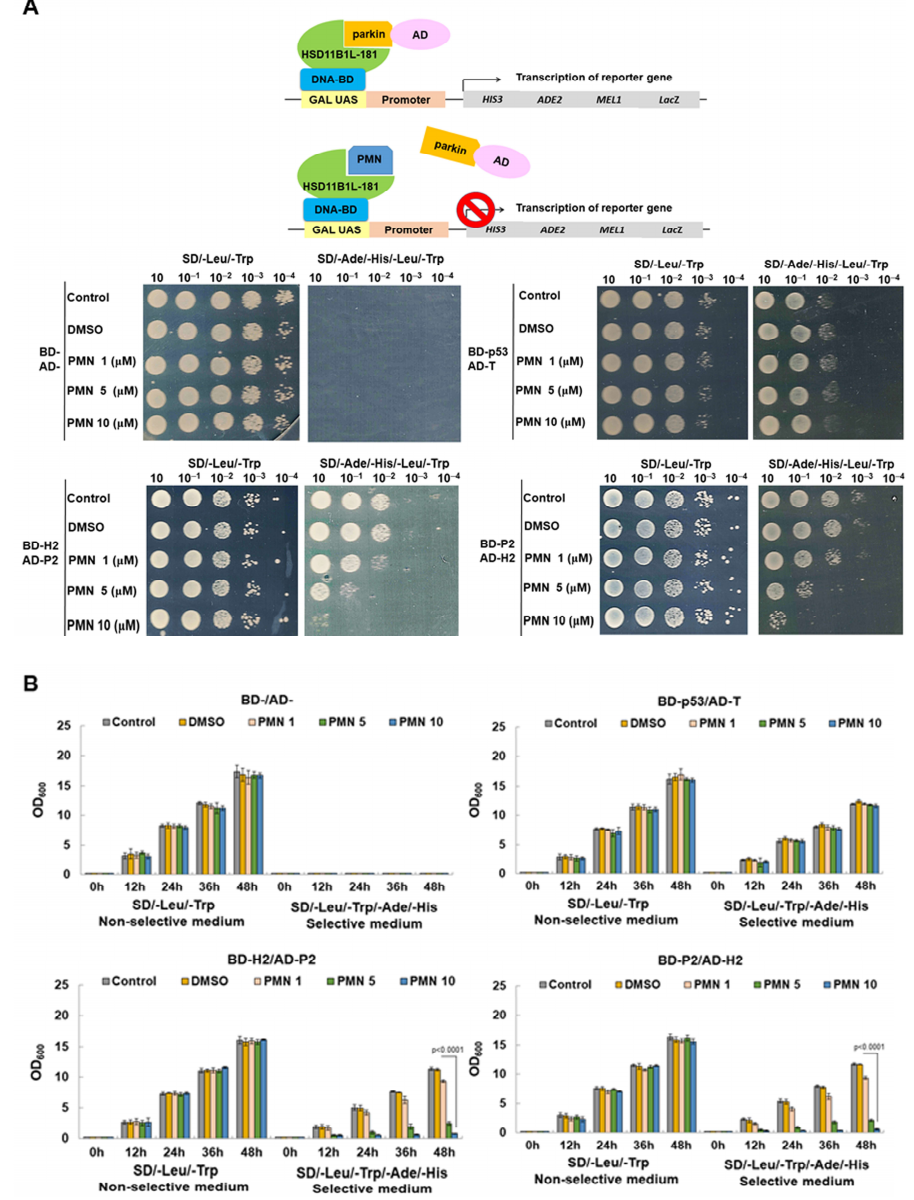
Figure 7. The interaction of HSD11B1L-181 with parkin is inhibited by PMN in a yeast two-hybrid model. ( A ) Schematic presenting the strategy for screening inhibitors of HSD11B1L-181 interaction with parkin using a yeast two-hybrid-based growth assay (top). Log-phase cultures of diploid cells expressing the indicated fusion proteins of BD and AD were spotted in the non-selective (-Leu-Trp) and selective (-Leu-Trp-Ade- His) plates including different PMN concentration and incubated at 30 °C for 3 days. ( B ) The indicated diploids, grown in nonselective media, were inoculated into selective and nonselective liquid media containing series dilutions of PMN. Diploid cells were diluted to OD 600 = 0.2 as the starting point and the OD was measured every 12 h for a total of 48 h. The bar graph shows the mean determination of OD 600 values from three experiments.